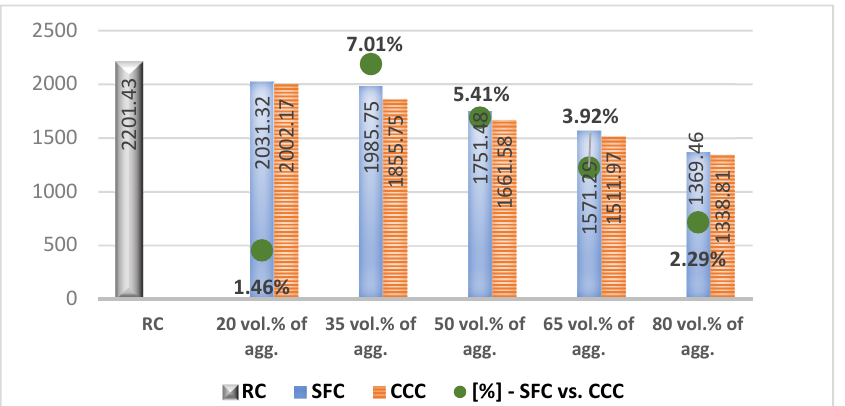
Figure 7. Apparent density of concrete with 20, 35, 50, 65 and 80% vegetal aggregates, measured 28 days after pouring [kg/m 3 ].